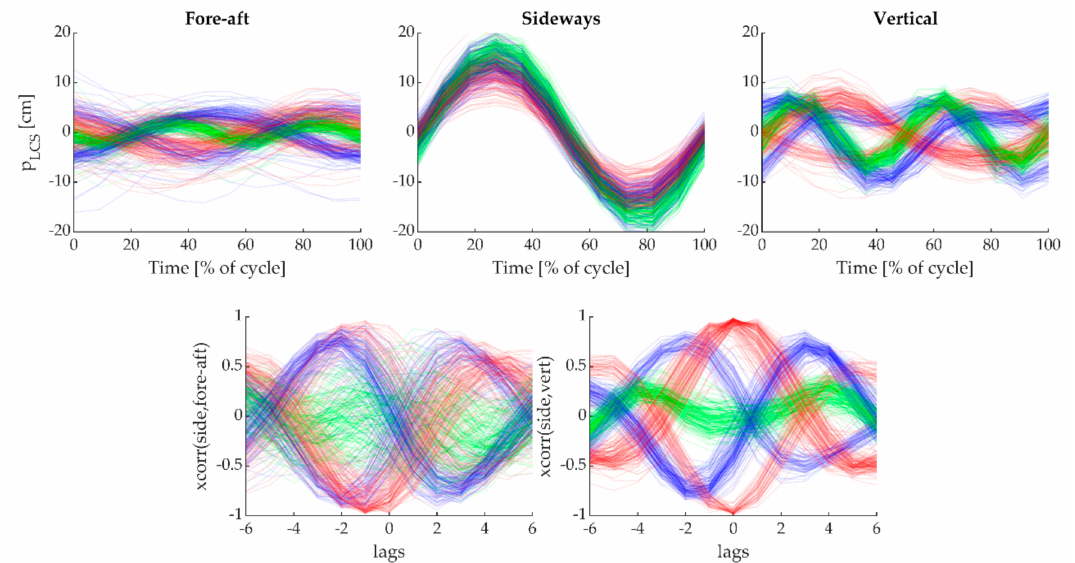
Figure 4. Data generated from the head position of the indoor treadmill trials. Top row: Head position normalized to a complete technique cycle (12 points per cycle) in the LCS. From left to right: fore-aft, sideways, and vertical directions. Colors: red, green and blue lines are G2, G3 and G4, respectively. Bottom row: waveforms generated by cross-correlating the curves in row 1. Left: fore-aft*sideways movement, right: vertical*sideways movement. The five main sub-techniques (including the left/right symmetric variants of G2 and G4) have distinct cross-correlation waveforms, particularly for the vertical*sideways